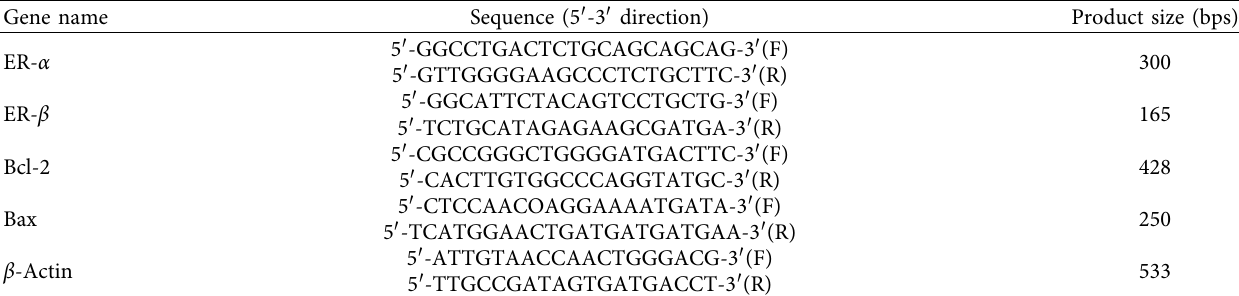
Table 1: Sequences of primers used for